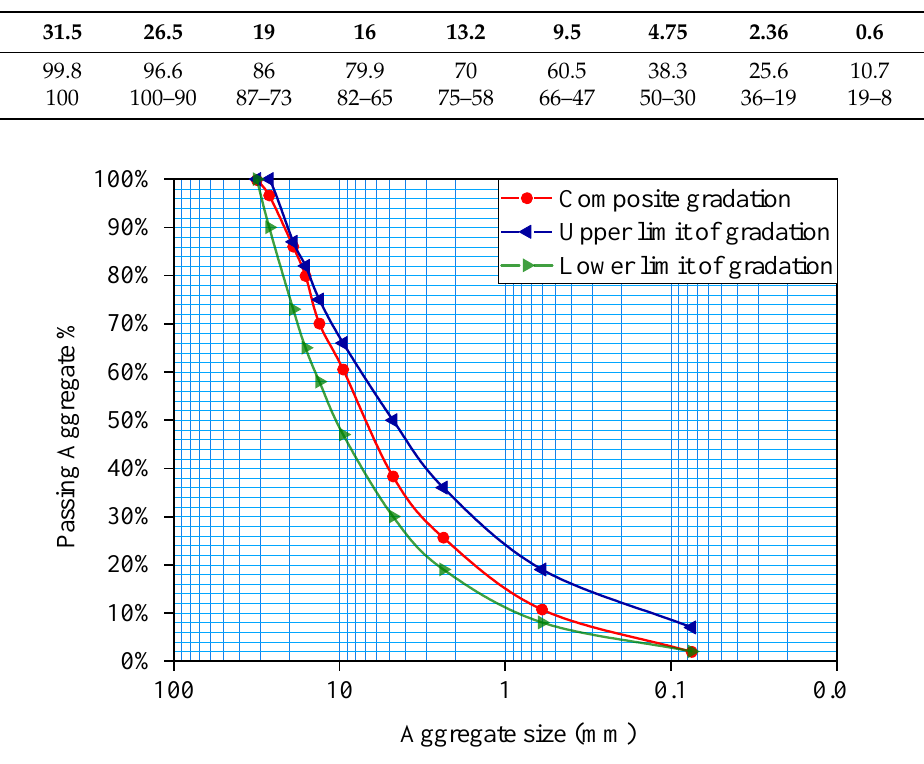
Figure 14. Grading curve of crushed stone.